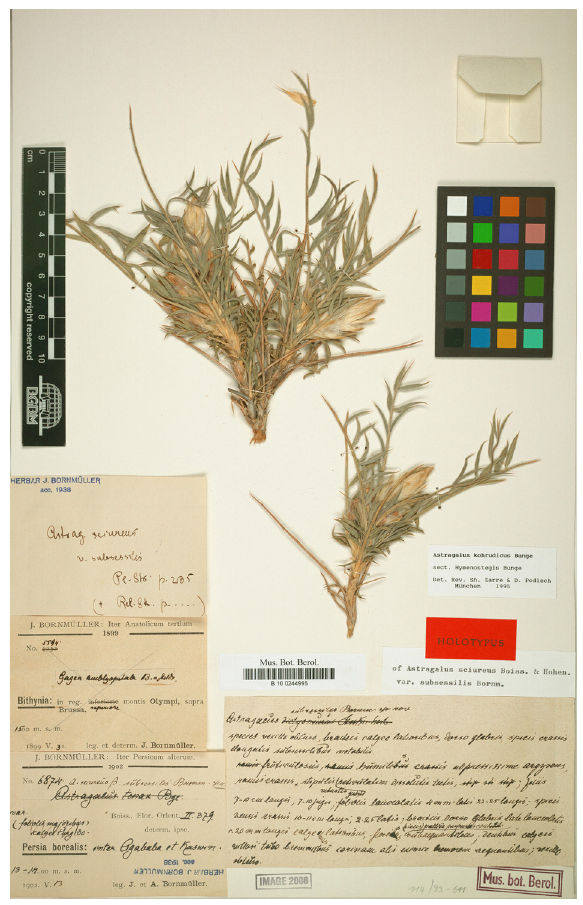
Fig 1. Holotype of Astragalus sciureus var. subsessilis = A . kohrudicus (digital barcode in B herbarium: B 10